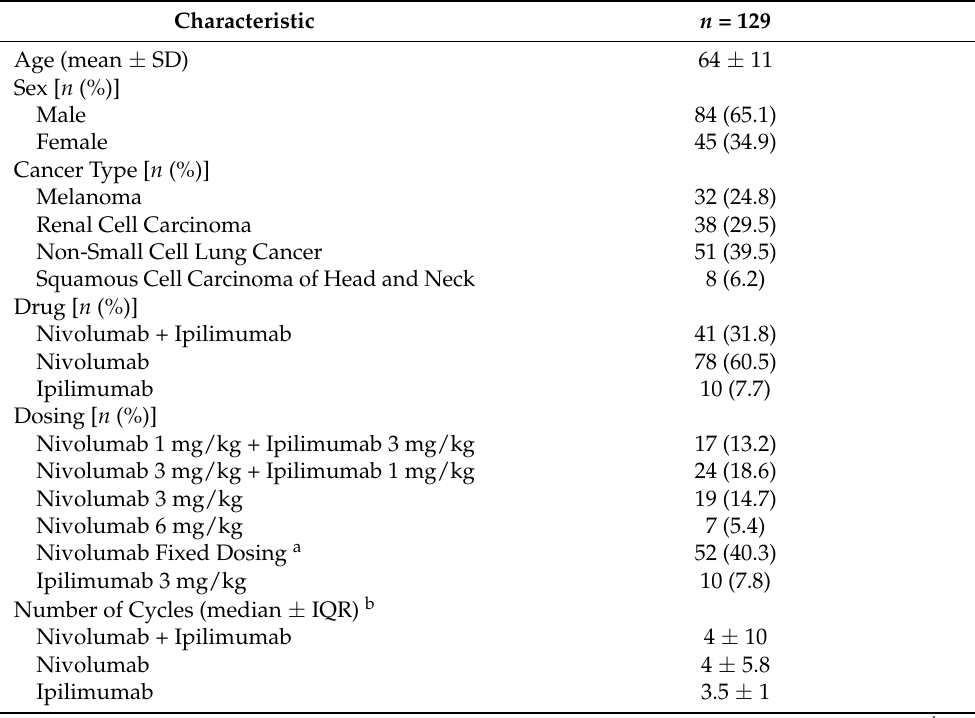
Table 1. Baseline characteristics of Nova Scotia Health-Central Zone medical oncology patients receiving nivolumab, ipilimumab, or nivolumab plus ipilimumab from 2013–2020 ( n = 129).